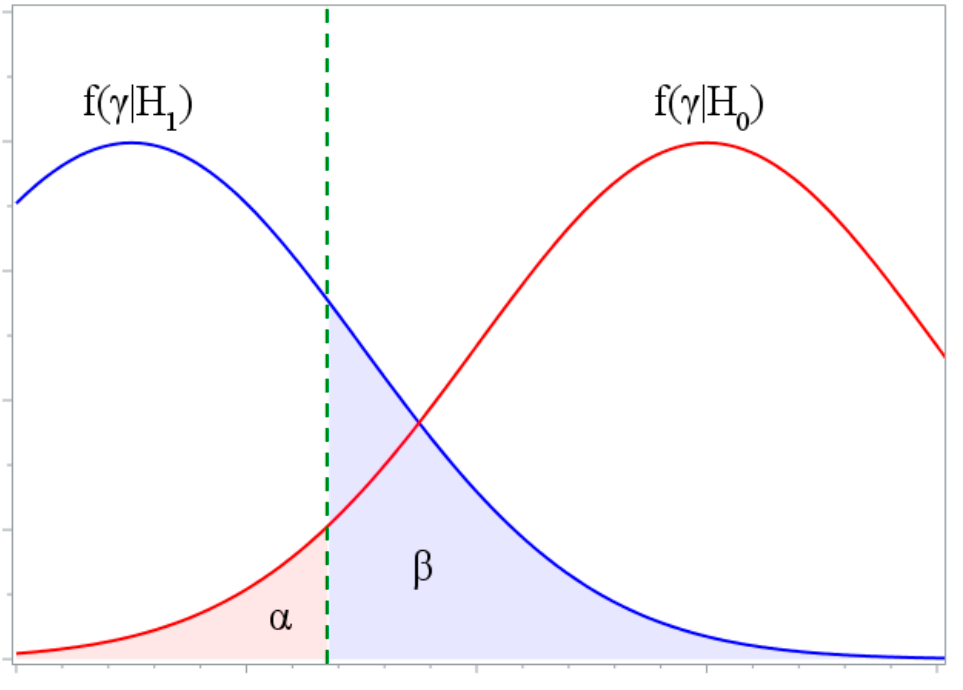
Figure 2. Illustration of the power.